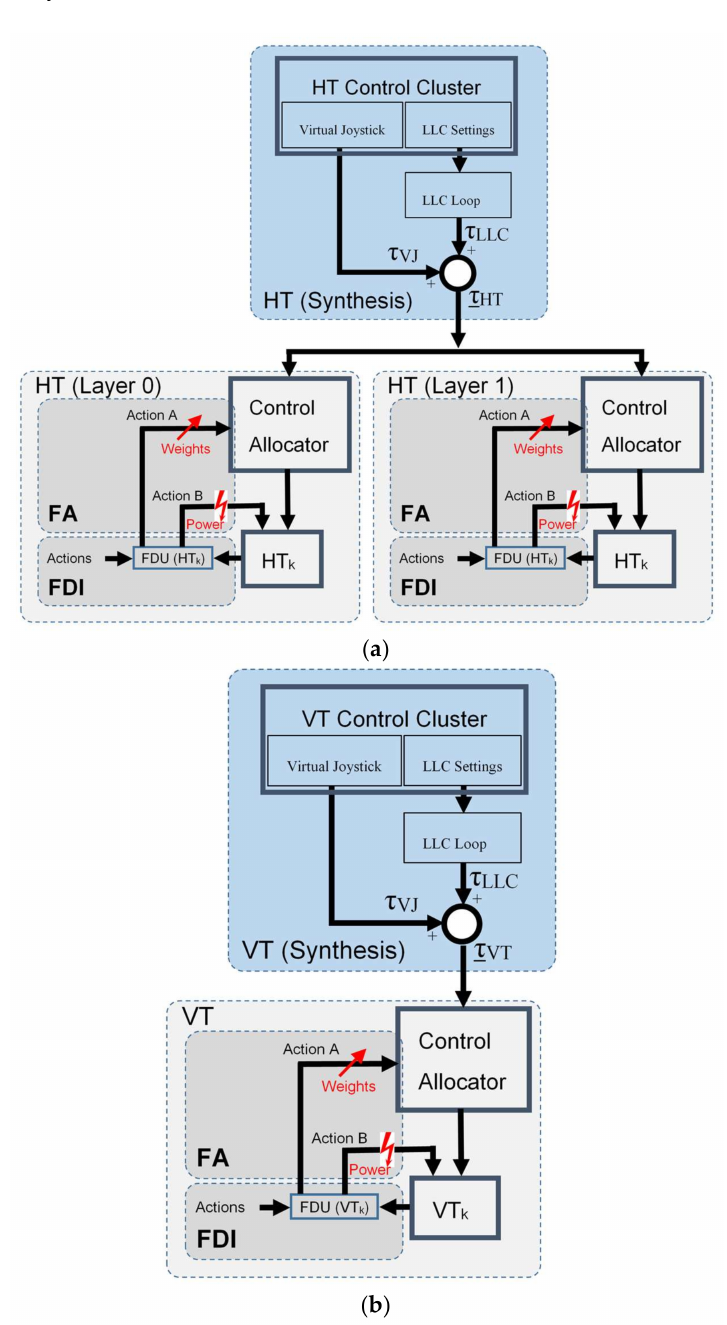
Figure 2. Architecture of the Fault Tolerant Control (FTC) system: ( a ) Horizontal Subspace (Plane); ( b ) Vertical Subspace